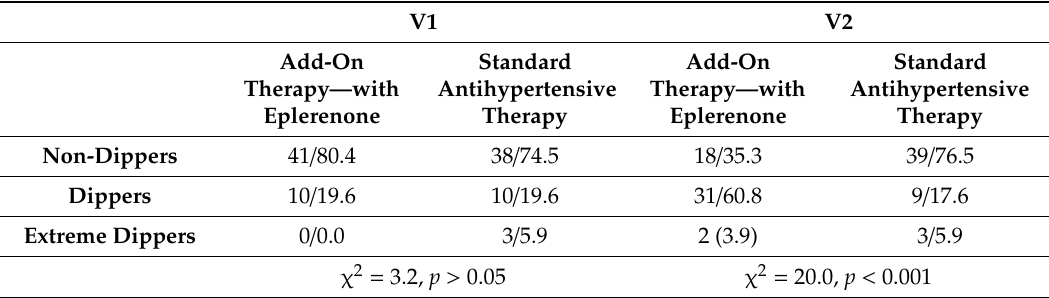
Figure 2. Changes in BP parameters during 6-month add-on treatment with eplerenone compared to standard antihypertensive therapy. Asterisks (***) denote statistically significant differences between groups (Mann–Whitney U test). SBP—systolic blood pressure; DBD—diastolic blood pressure; MAP—mean arterial pressure. Table 3. Frequency ( n / %) of non-dippers, dippers, and extreme dippers in the group with add-on treatment with eplerenone (50 mg / day) and standard antihypertensive treatment before (V1) and after 6 months (V2).